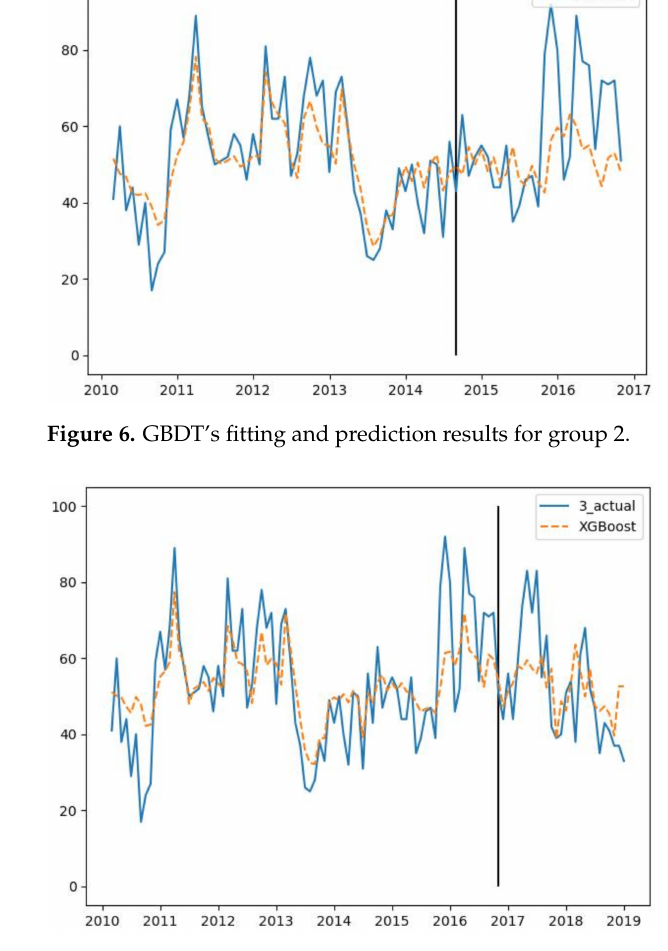
Figure 7. GBDT’s fitting and prediction results for group